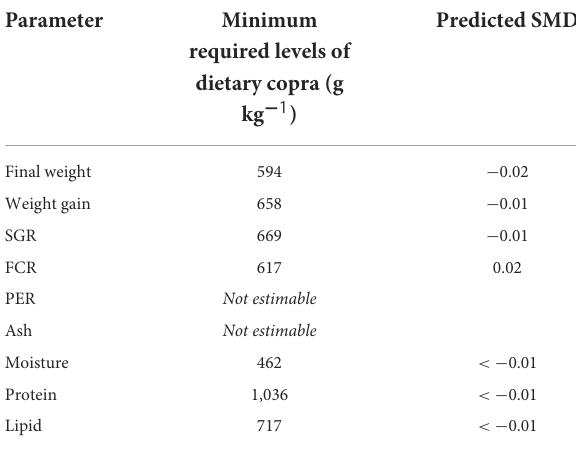
TABLE 11 Minimum required inclusion levels of dietary copra per